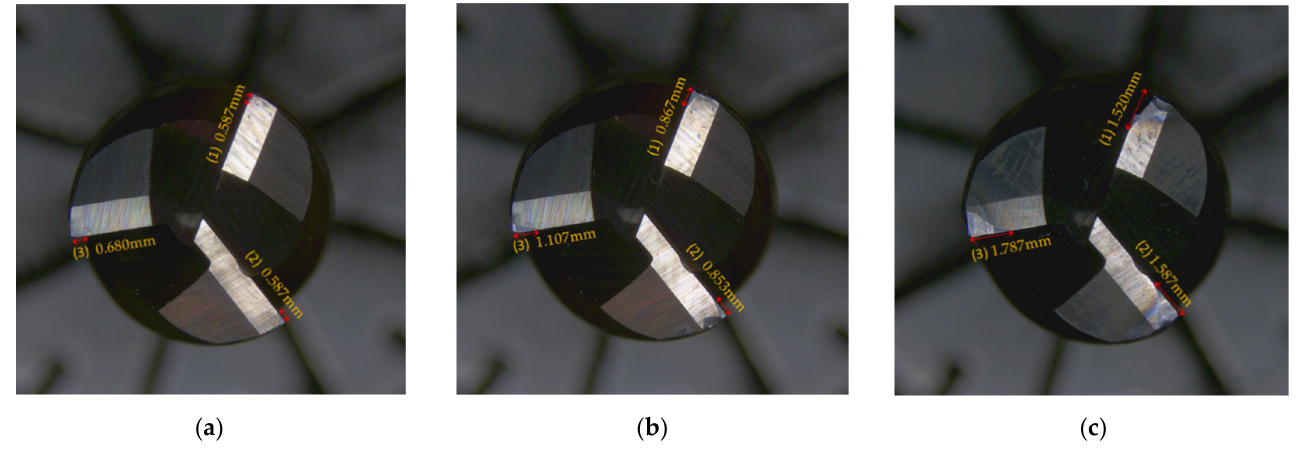
Figure 6. Tool wear images of different tooling processes. ( a ) Wear of first tooling process, ( b ) wear of fifth tooling process, and ( c ) wear of tenth tooling process.